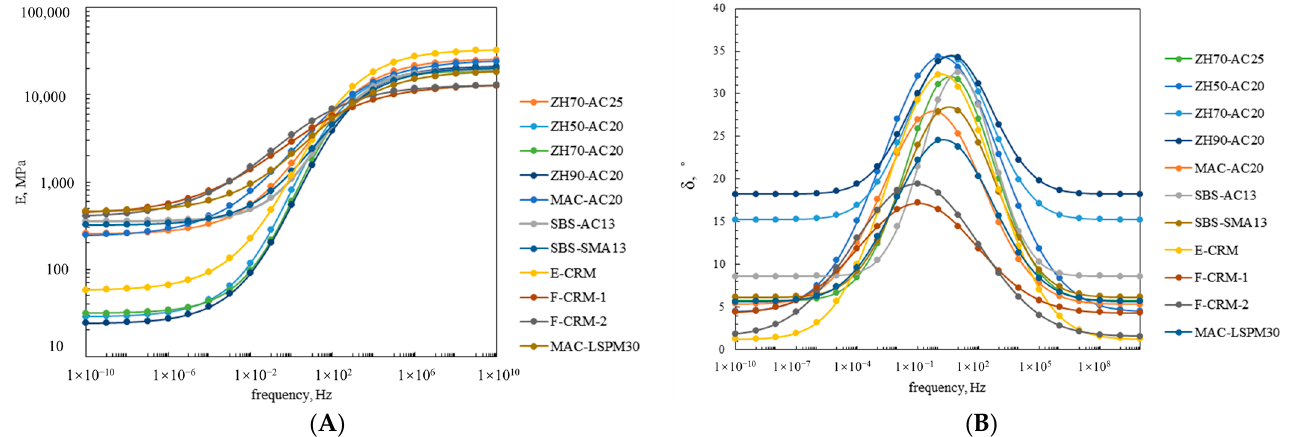
Figure 11. Comparison of master curves of different asphalt mixtures. ( A ) Dynamic modulus master curve, ( B ) Phase angle master curve.